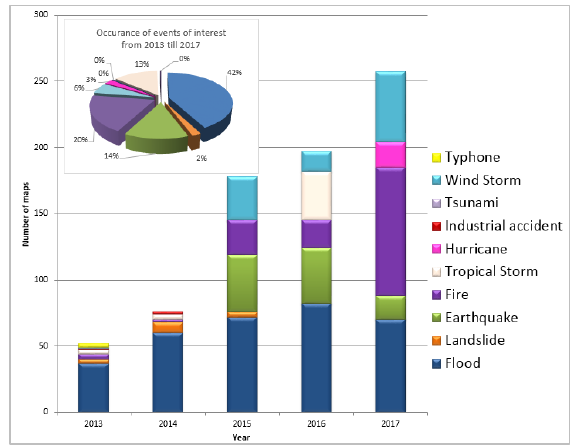
Figure 1. Distribution of the maps considered as representative sample over the time per type of the